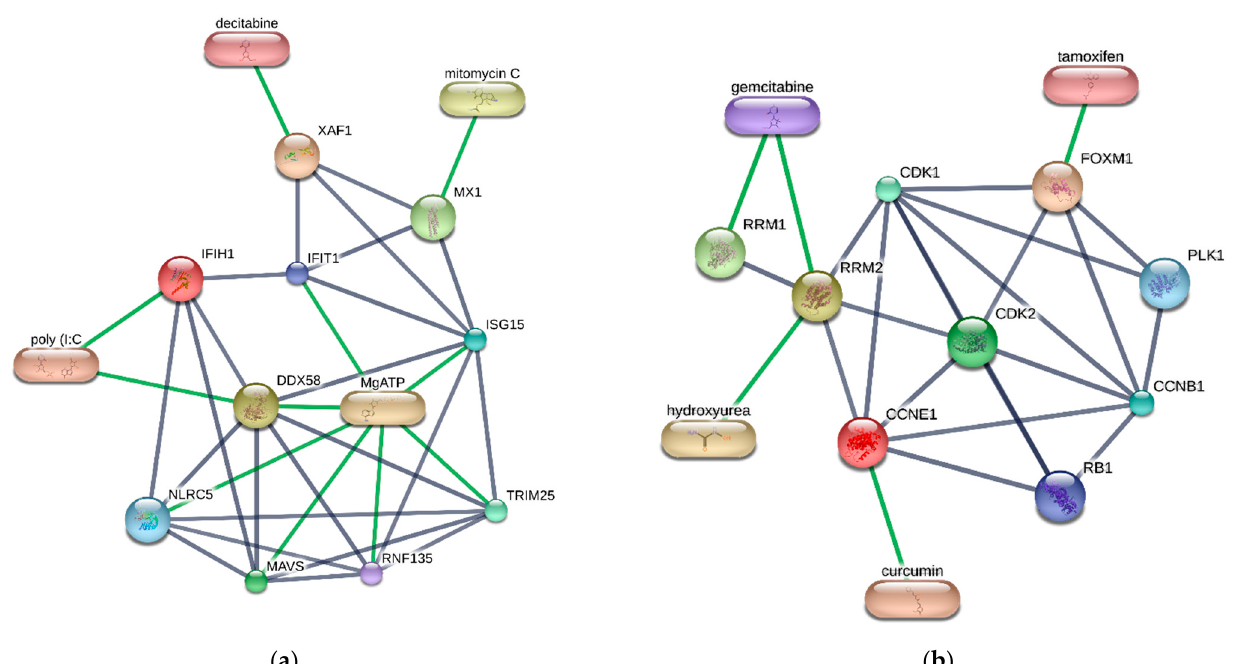
Figure 9. Drug–protein interaction network of candidate drugs targeting the key proteins resulted from STITCH v5.0. ( a ) Drug–proteins interaction network involved in innate immune response and apoptosis. ( b ) Drug–proteins interaction network involved in cell cycle regulation. Grey and green edges represent protein–protein and drug–protein interactions, respectively.